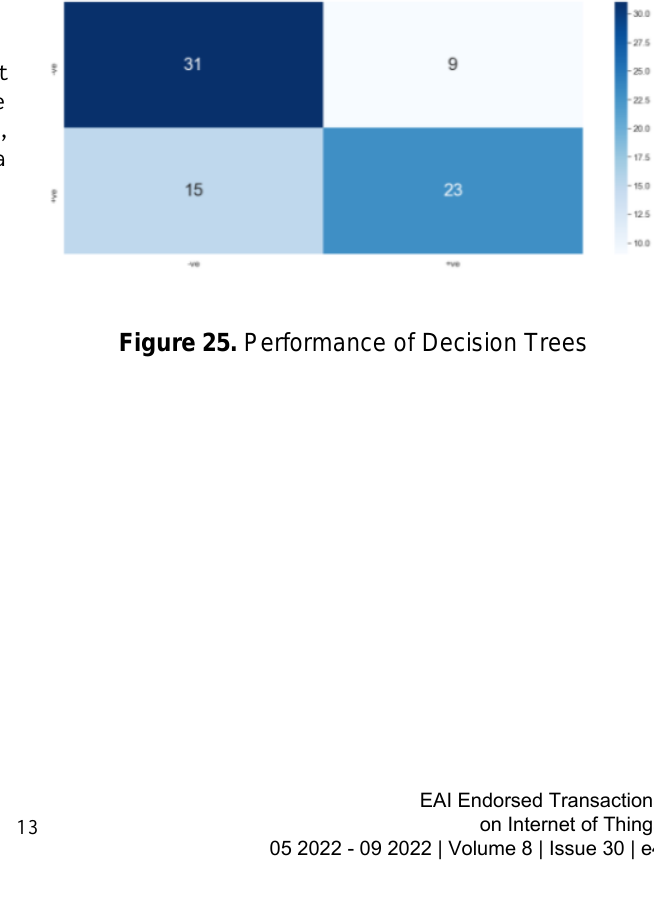
Figure 22. Performance of KNN